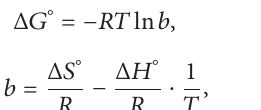
versus of AO-7 on ANP 𝐶𝐶 𝑒𝑒 𝑞𝑞 𝑒𝑒